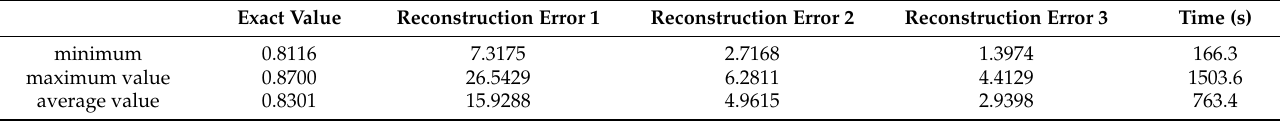
Table 4. DBN: X600-300-100 statistical results.